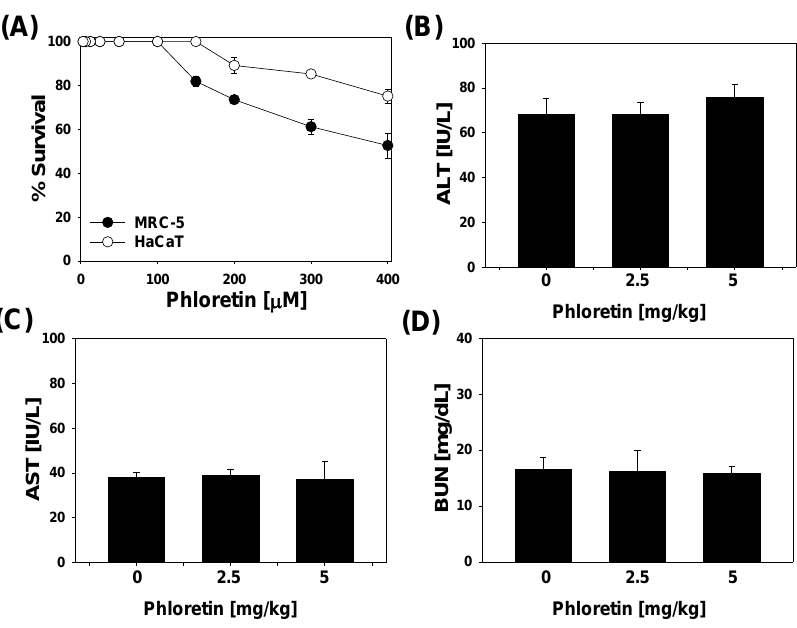
Figure 7. ( A ) Cell viability upon treatment with phloretin. MRC-5 human lung fibroblasts and HaCaT non-cancerous human keratinocytes were treated with phloretin for 24 h and viability was assessed with the 3-(4,5-dimethylthiazol-2-yl)2,5-diphenyl tetrazolium bromide (MTT) assay; the effects of phloretin on serum levels of ( B ) alanine transaminase (ALT); ( C ) aspartate aminotransferase (AST); and ( D ) blood urea nitrogen (BUN). Data represent mean ± standard deviation.